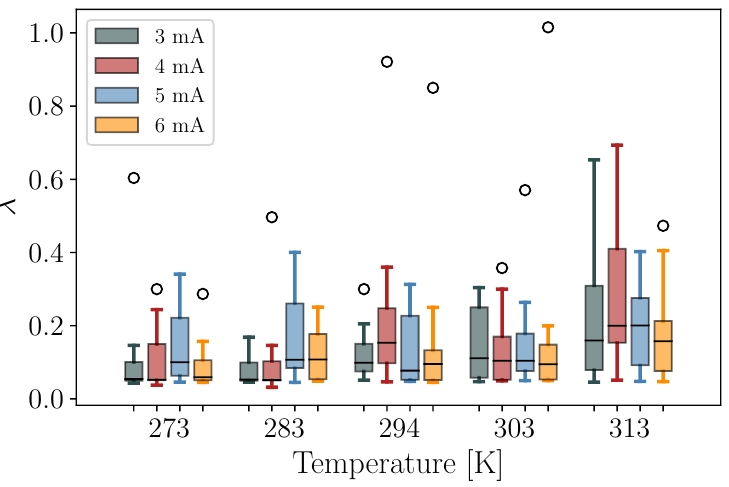
Figure 5. Calculation of the regularization parameter λ depending on the temperatures between 273 K and 313 K as well as on the currents 3 mA to 6 mA. A boxplot represents the calculation of λ at each measured SoC. The black line within the box indicates the median and the circles show